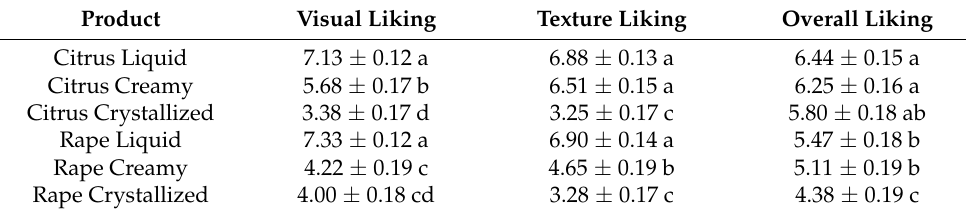
Table 11. Mean liking scores on a 9-point hedonic scale ( ±